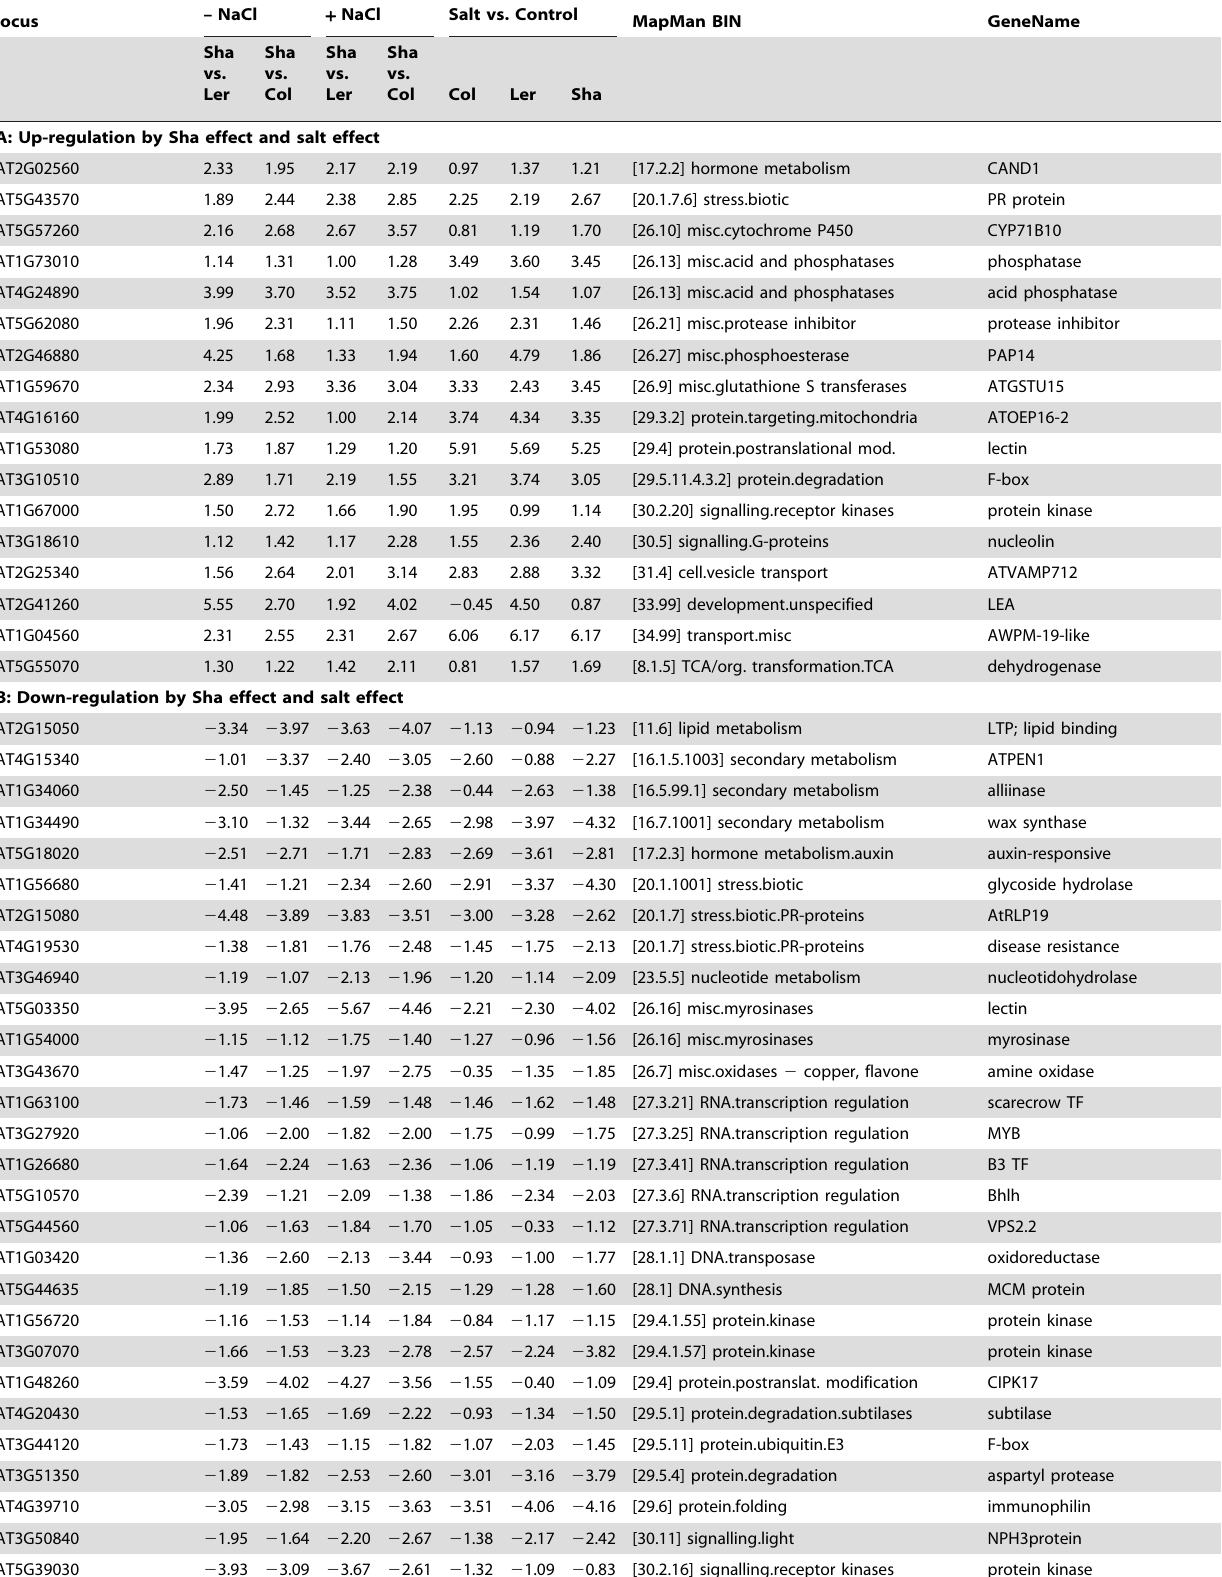
locus – NaCl + NaCl Salt vs. Control MapMan BIN GeneName